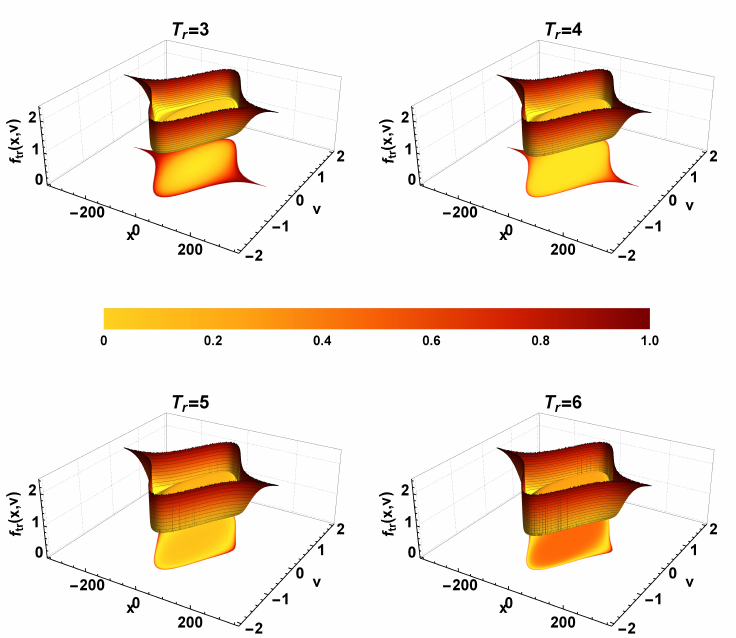
Figure 13. The same as Figure 12, except that δ = 40 and ψ = 3 are used. The input parameters are from Region 2. The central hump characterizes the phase space distribution for all the cases considered